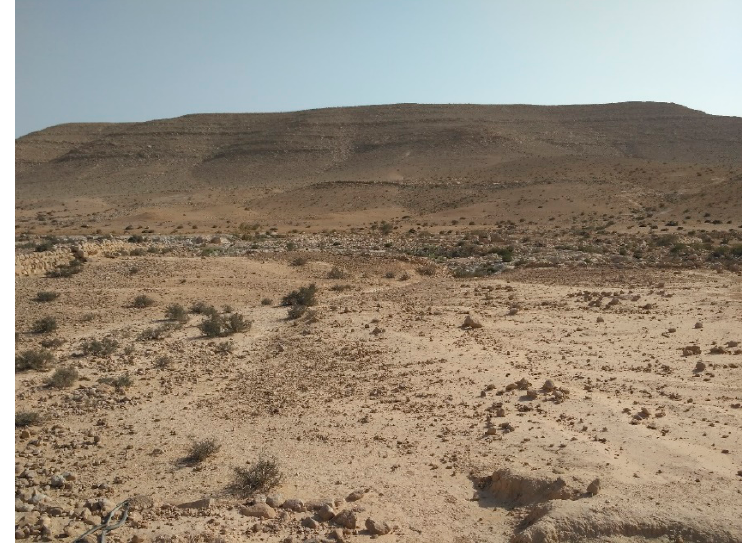
Figure 3. A collapsed-terrace plot; downslope view. Photo taken by E. Groner, on summer 2017.